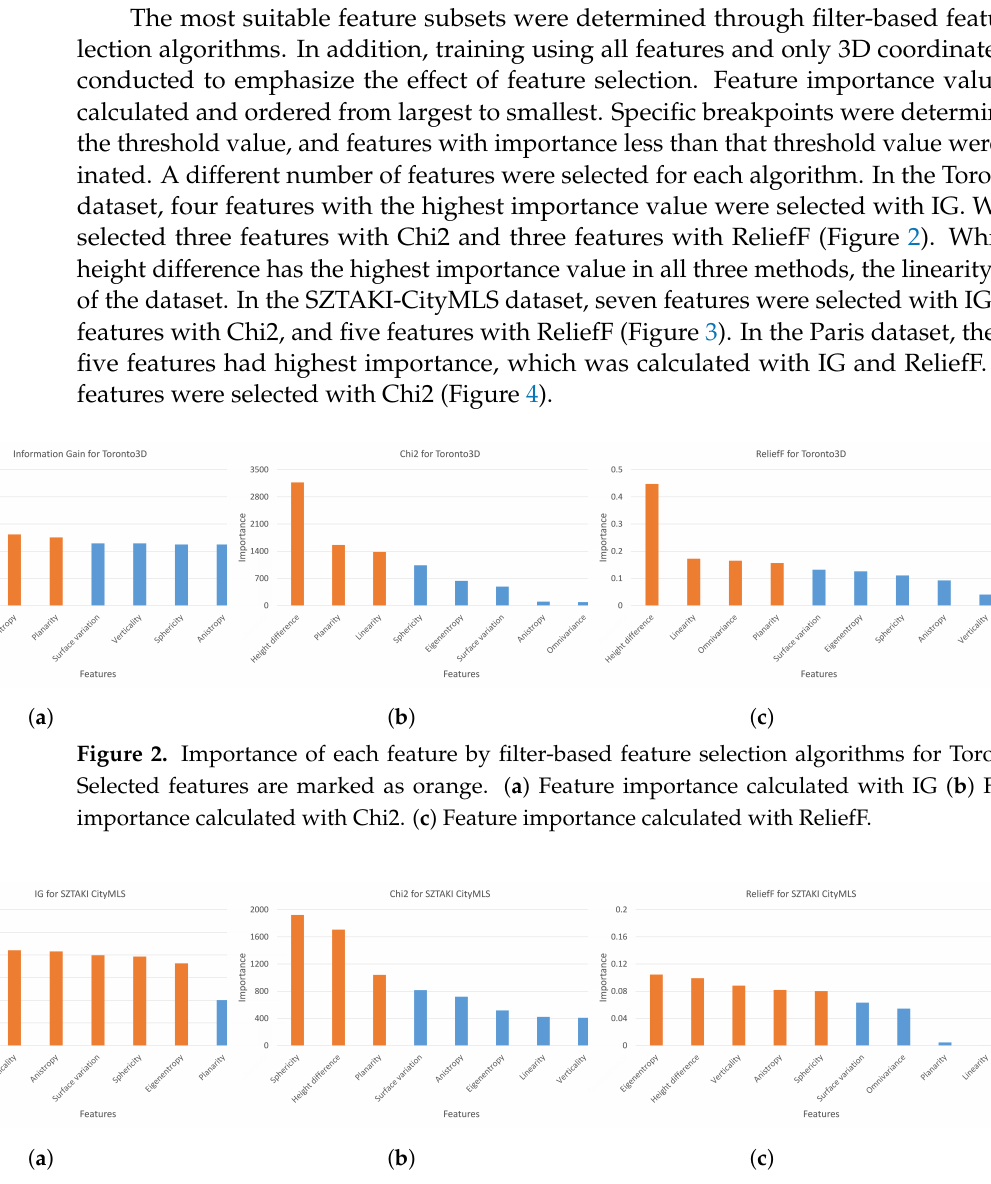
Figure 3. Importance of each feature calculated using filter-based feature selection algorithms for SZTAKI-CityMLS. Selected features are marked as orange. ( a ) Feature importance calculated with IG ( b ) Feature importance calculated with Chi2. ( c ) Feature importance calculated with